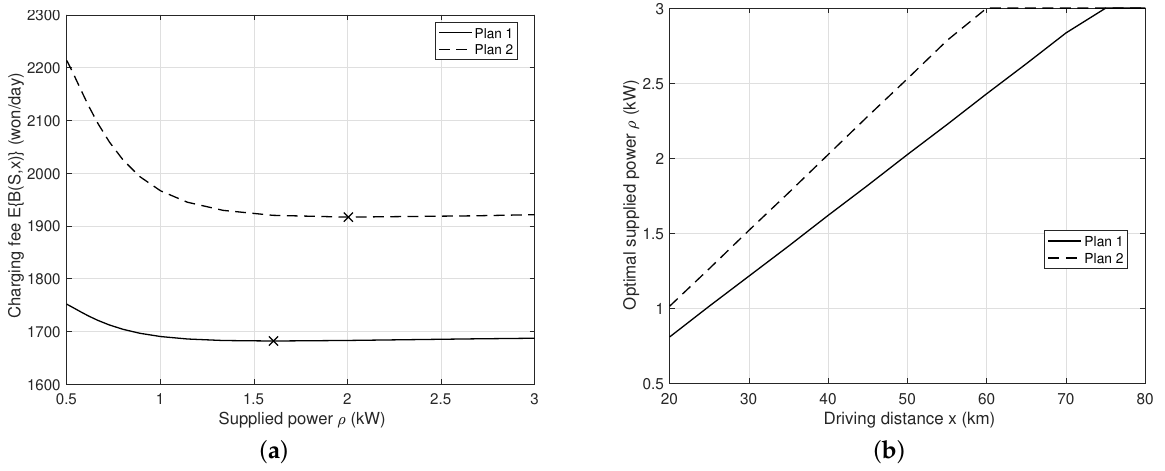
Figure 10. Charging fee E { B ( S , x ) } with respect to the supplied power ¯ ρ for the slow-rate plans and the charging start time distribution f S of Figure 5 ( α = 5.2 km/kWh, η = 0.95, and KRW 1000 is USD 0.83). ( a ) Charging fee curve for the driving distance of x = 39.6 km. The minimum charging fee is KRW 1682 at ¯ ρ = 1.61 kW. ( b ) Optimal supplied mean power with respect to the driving